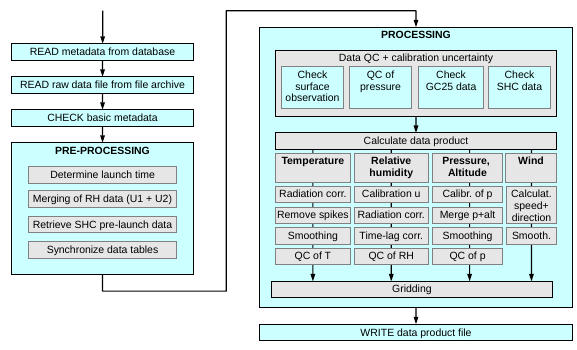
Figure 2. Schematic representation of the data flow, processing steps, quality control (QC) and correction algorithms applied in the GRUAN processing. SHC denotes Standard Humidity Chamber (see Sect. 3.1). In the final step before the data is written to file, “gridding”, the temporal sampling of the profile is reduced from one second to an integer number of choice. In the GRUAN processing as described in this paper, the temporal sampling remains one second.